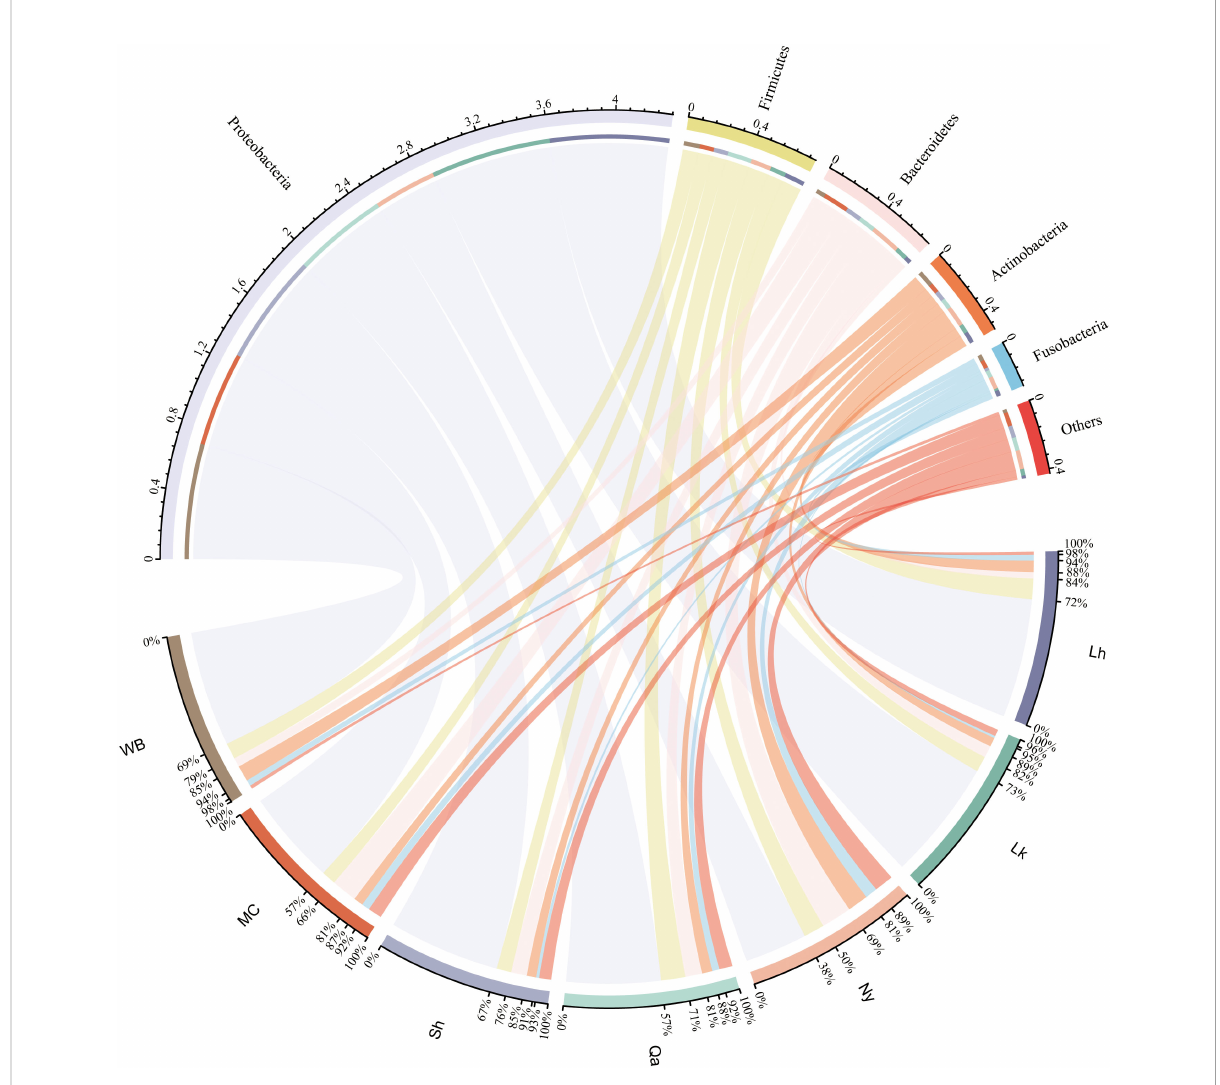
FIGURE 2 Composition of endophytic bacteria in different types of qingke seeds. Only the top 5 most abundant phyla are displayed, and the less abundant phyla are summarized as “ Others ”